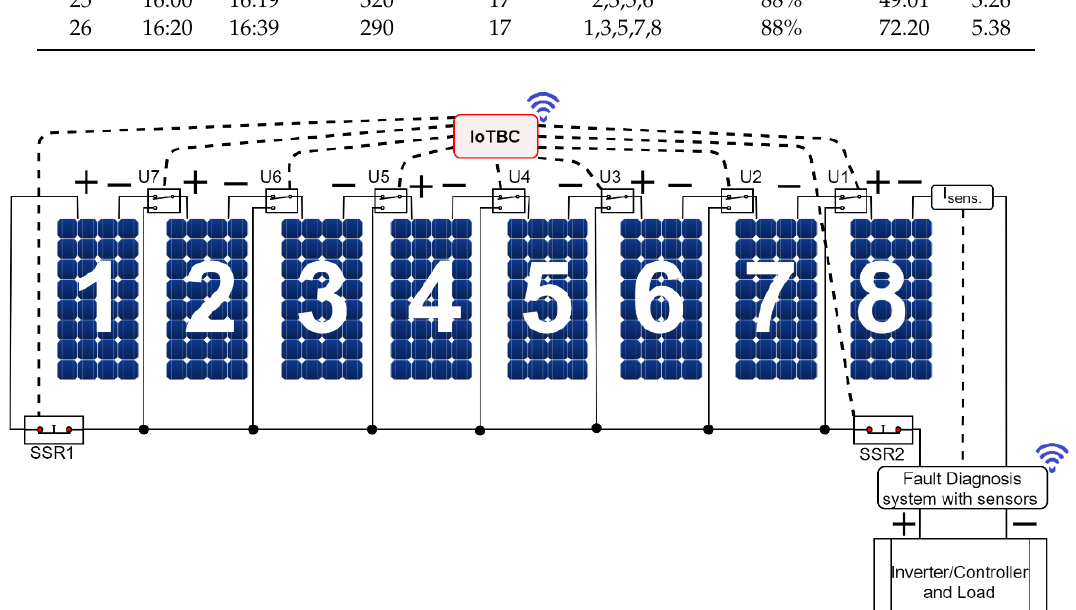
Figure 14. The experimental setup of a PV (Astronergy-CHSM6610P) system.